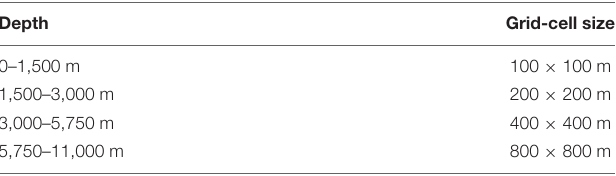
TABLE 1 | Seabed 2030 resolution targets at different depth ranges (Mayer et al., 2018).